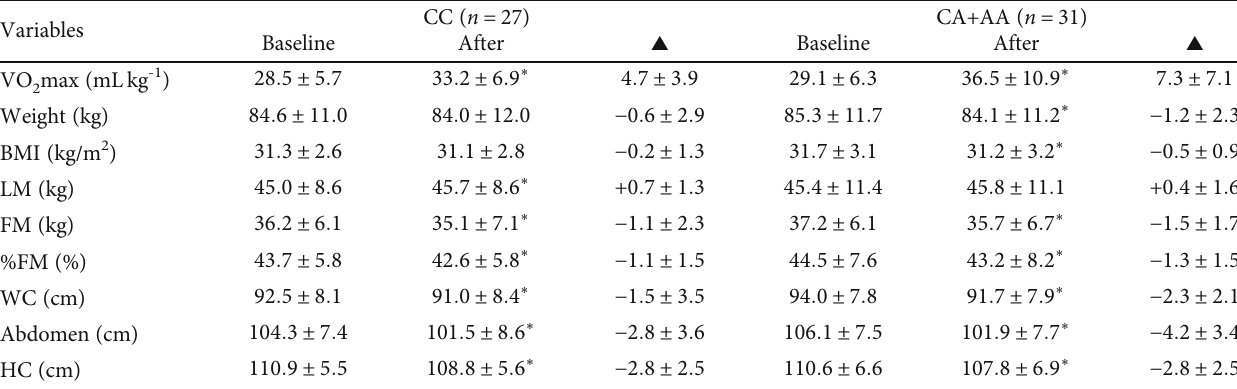
Table 3: Comparison between e ff ect of training on aerobic capacity and body composition of people with allele C versus A. Variables